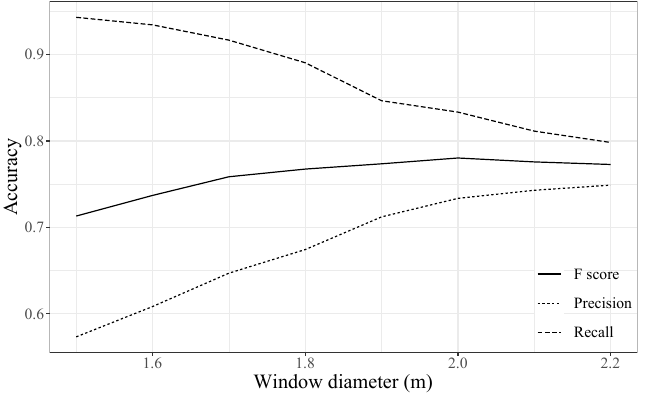
Figure 4. Accuracy of treetop detection with different moving window diameters of the local maxima filter (LMF) in site 2. Precision is TP/ ( TP + FP ) , recall is TP/ ( TP + FN ) and F score is 2 × precision × recall/ ( precision + recall ) , where, TP, FP and FN denote true positive, false positive and false negative, respectively.